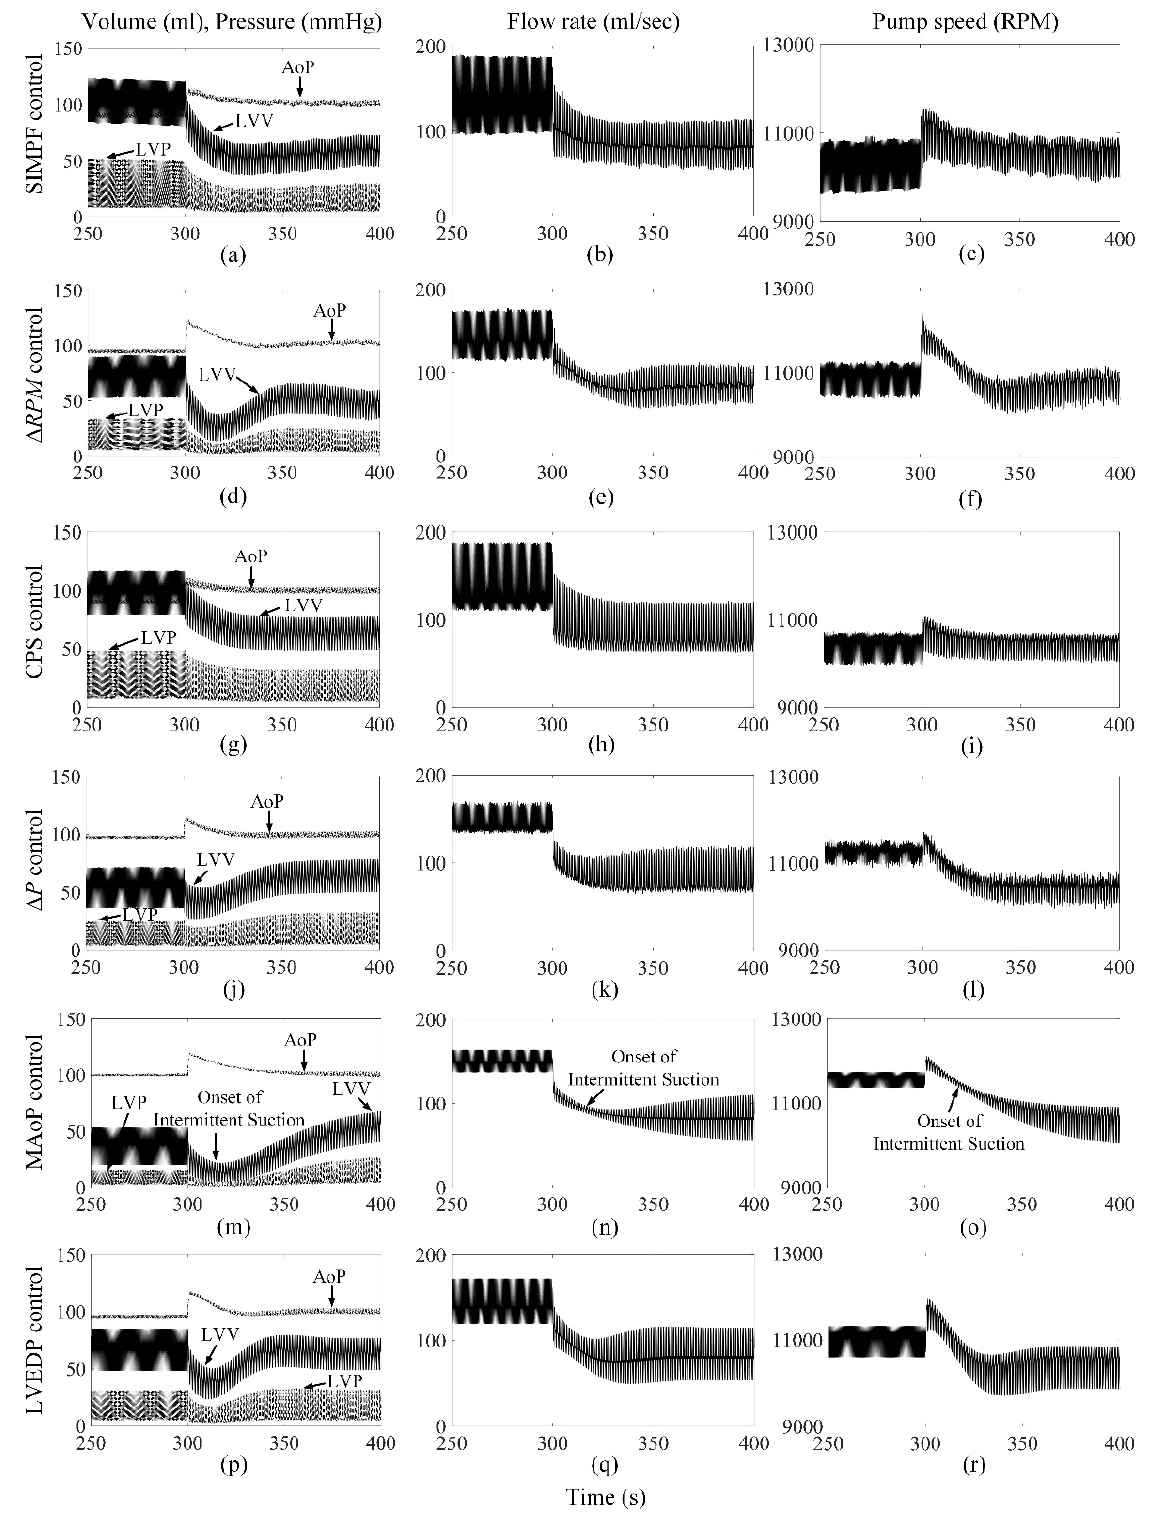
Figure 4. Comparison of performance among six control strategies under step change from exercise to rest for AFP. The transition started when t = 300 s. ( a − c ) SIMPF control with 5% noise. ( d − f ) ∆ RPM control. ( g − i ) CPS control. ( j − l ) ∆ P control. ( m − o ) MAoP control. ( p − r ) LVEDP control. Intermittent suction events were found for the MAoP control